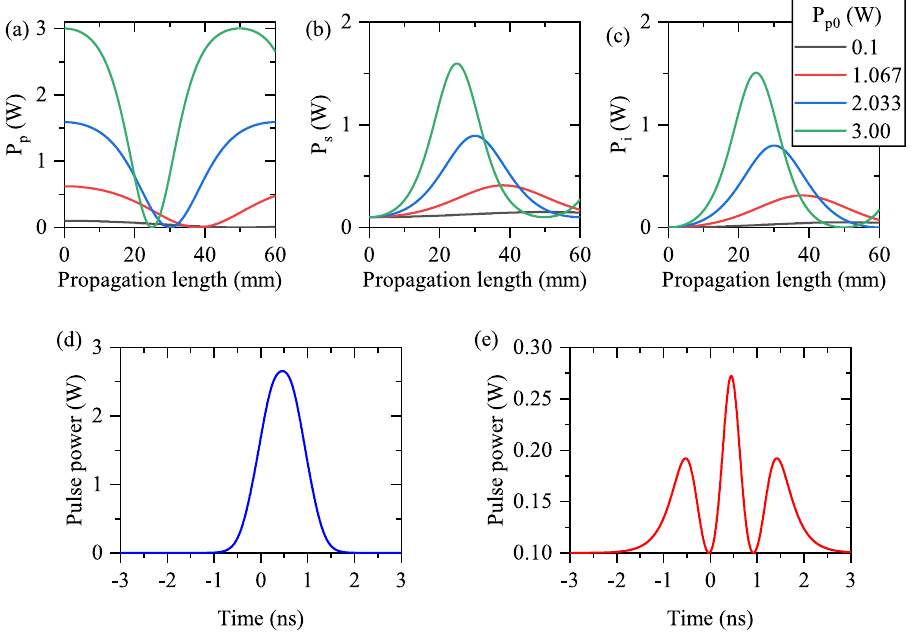
Figure 4. Propagation of different components of pump ( a ), signal ( b ), and idler ( c ) modes along a 60mm PPLN waveguide for the CW-DFG process when �β = 0 (homogeneous waveguide) is satisfied, with different values of P p 0 = 0.1, 1.067, 2.033, 3.00 W . Out-coupled pump ( d ) and signal ( e )